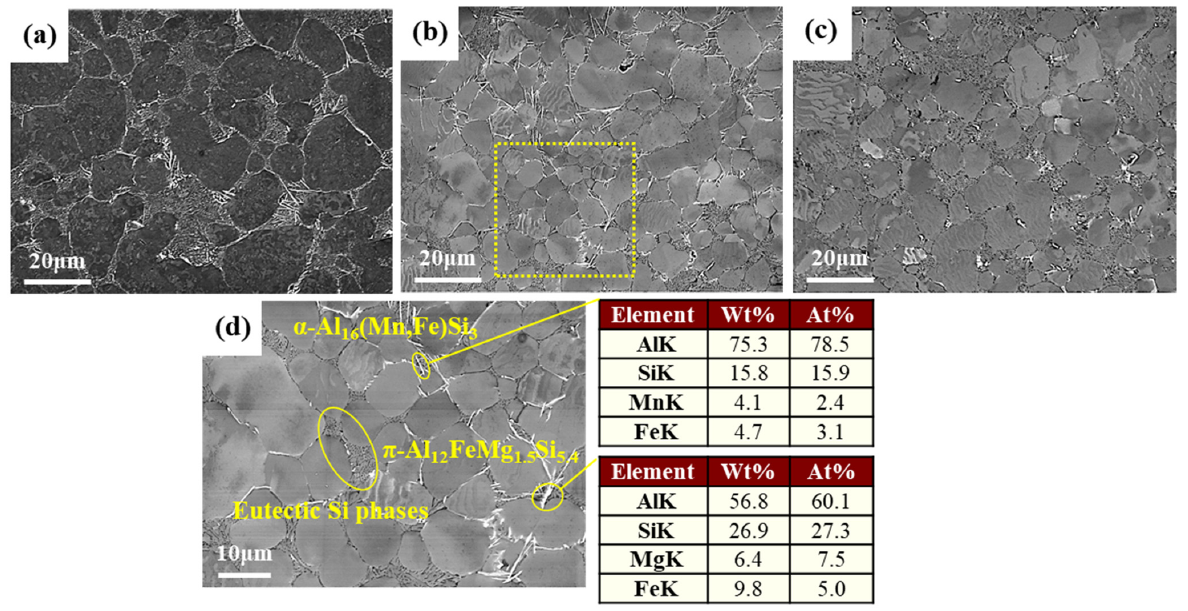
Figure 1. SEM and EDS analysis of microstructure of crept HPDC AA365 alloys: ( a ) crept AA365 alloy at 373 K; ( b ) crept AA365 alloy at 473 K; ( c ) crept AA365 alloy at 573 K; ( d ) A higher magnification micrograph and EDS analysis of crept AA365 alloy at 473 K.